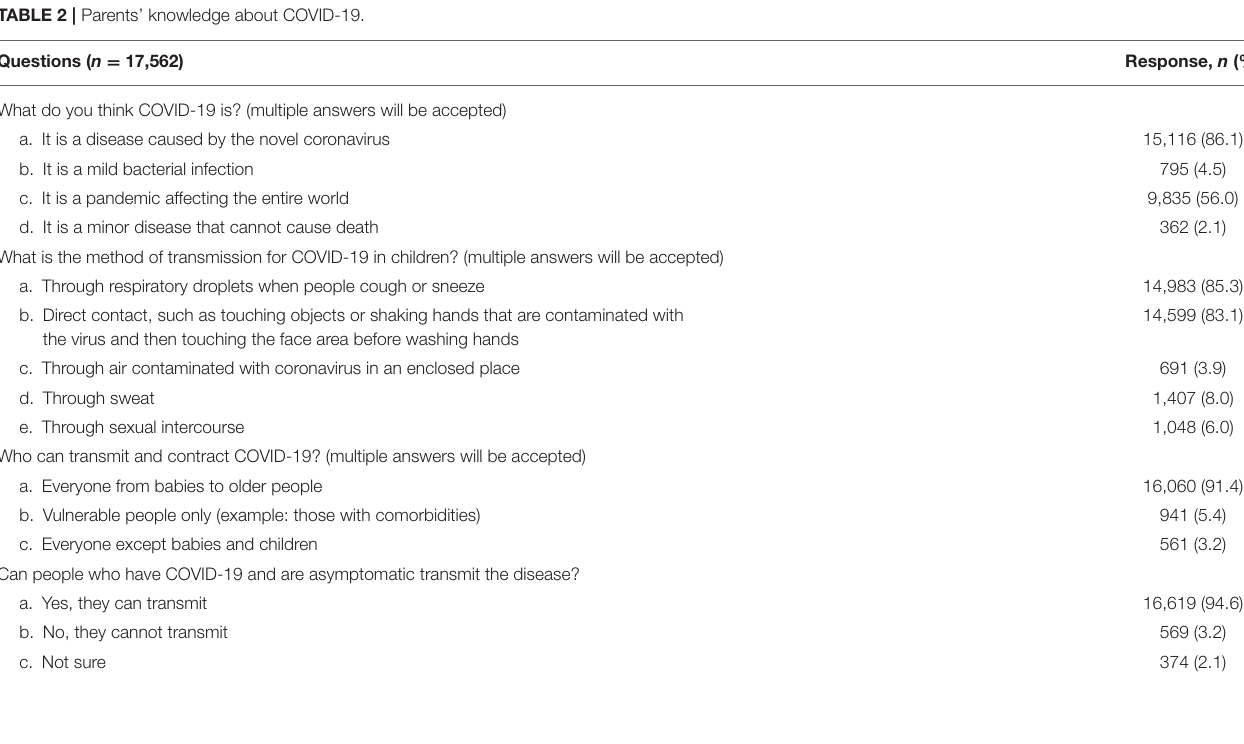
TABLE 2 | Parents’ knowledge about